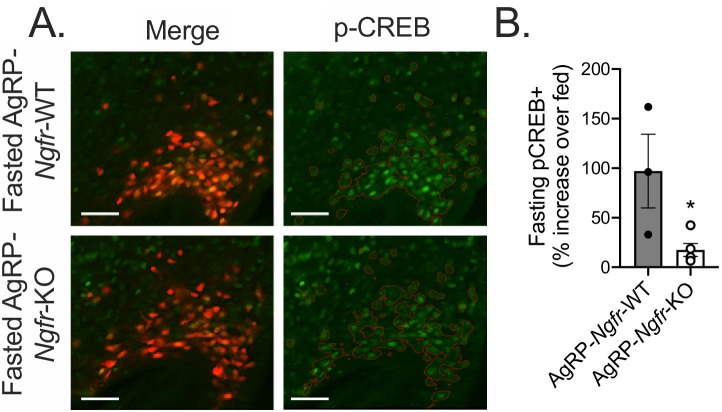
AgRP-Ngfr-KO mice have blunted activation of fasting CREB in AgRP neurons.(A) Immunofluorescent staining for pCREB in 16 hr overnight fasted mice co-expressing tdTomato from the AgRP promoter. Red lines indicate the approximate boundaries of AgRP-tdTomato expression. Scale bar = 50 µM. (B) Quantification of the percent increase of pCREB+/AgRP+ areas in each fasted AgRP-Ngfr-WT or AgRP-Ngfr-KO mouse relative to the average of pCREB+/AgRP+ areas of fed AgRP-Ngfr-WT or fed AgRP-Ngfr-KO. *p=0.0316 by Student’s t-test. n = 3–5/group. Data are presented as mean ± SEM.